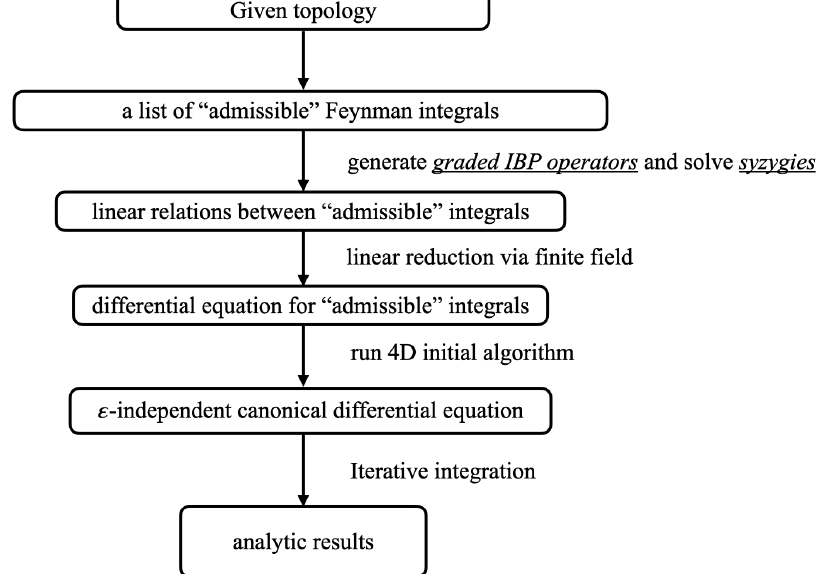
Figure 5. The algorithm flow chart of our